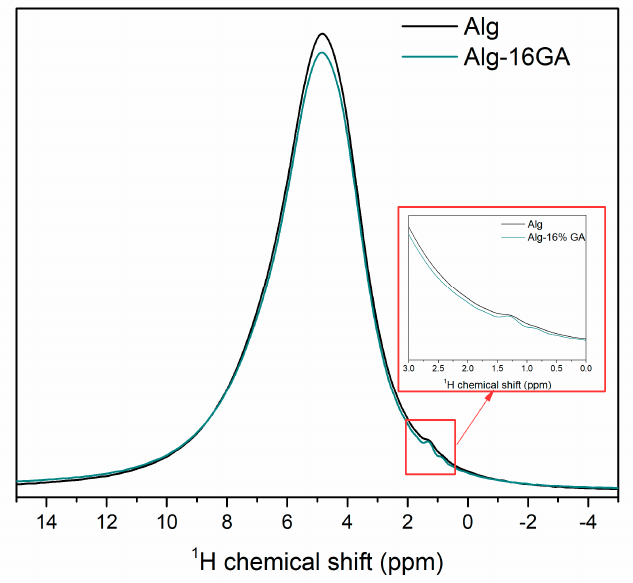
Figure 2. 1 H-NMR spectra of the alginate and Alg-16GA composite. The insert graph shows the enlarged part of the 1 H-NMR spectra .